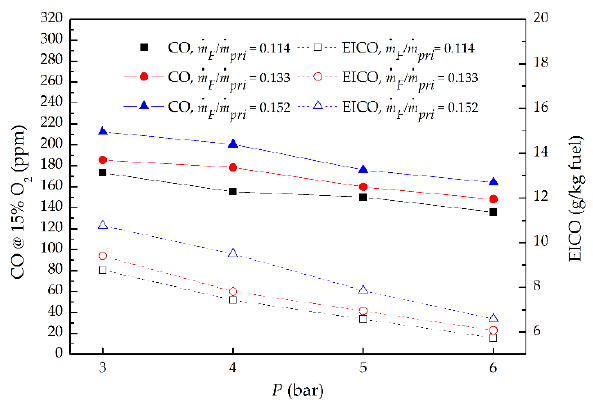
Figure 17. The CO and EINO for combustor pressure under varying ṁ F / ṁ pri ratios.